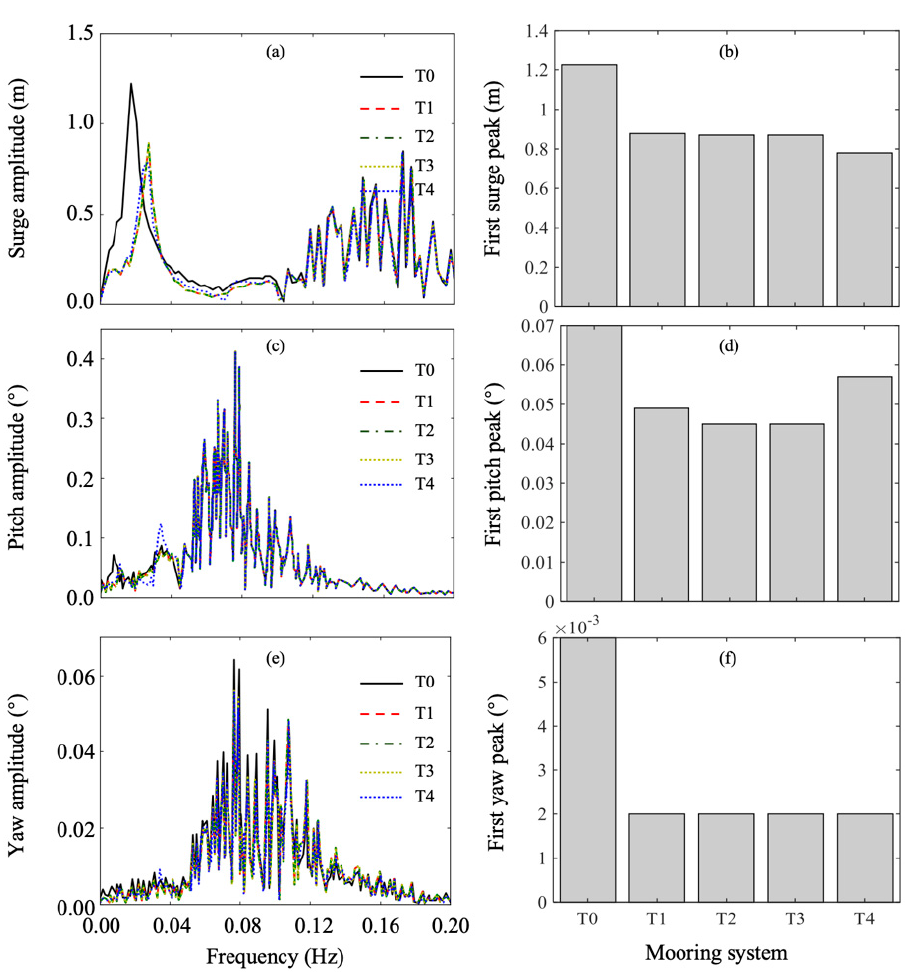
Figure 15. Frequency − amplitude curve and first peak amplitude in C6: ( a ) and ( b ) surge; ( c ) and ( d ) pitch; ( e ) and ( f ) yaw.